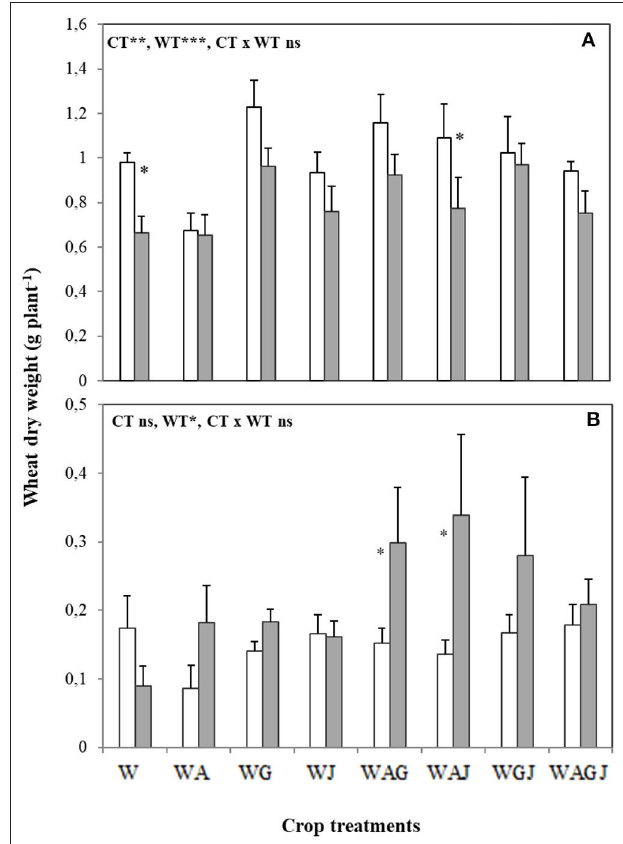
FIGURE 1 | Dry weight of shoot (A) and root (B) of spring wheat ( Triticum aestivum L. cv Dack) grown as a sole crop or intercropped with the three faba bean varieties Alexia (A), Gloria (G), and Julia (J) under adequate watering (80% field capacity; open bars) vs. water-stressed (30% field capacity, filled bars) conditions. Data are means and SE of six replicates harvested at 49 days post-transplantation. *Significant difference at p < 0.05.